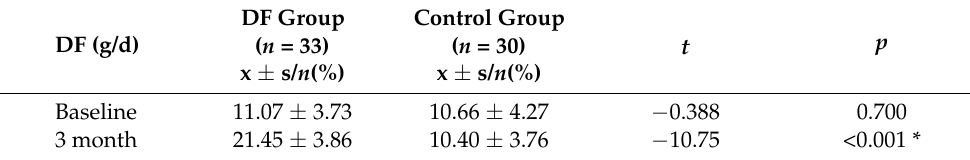
Table 3. Comparison of the quantity of DF intake between the two